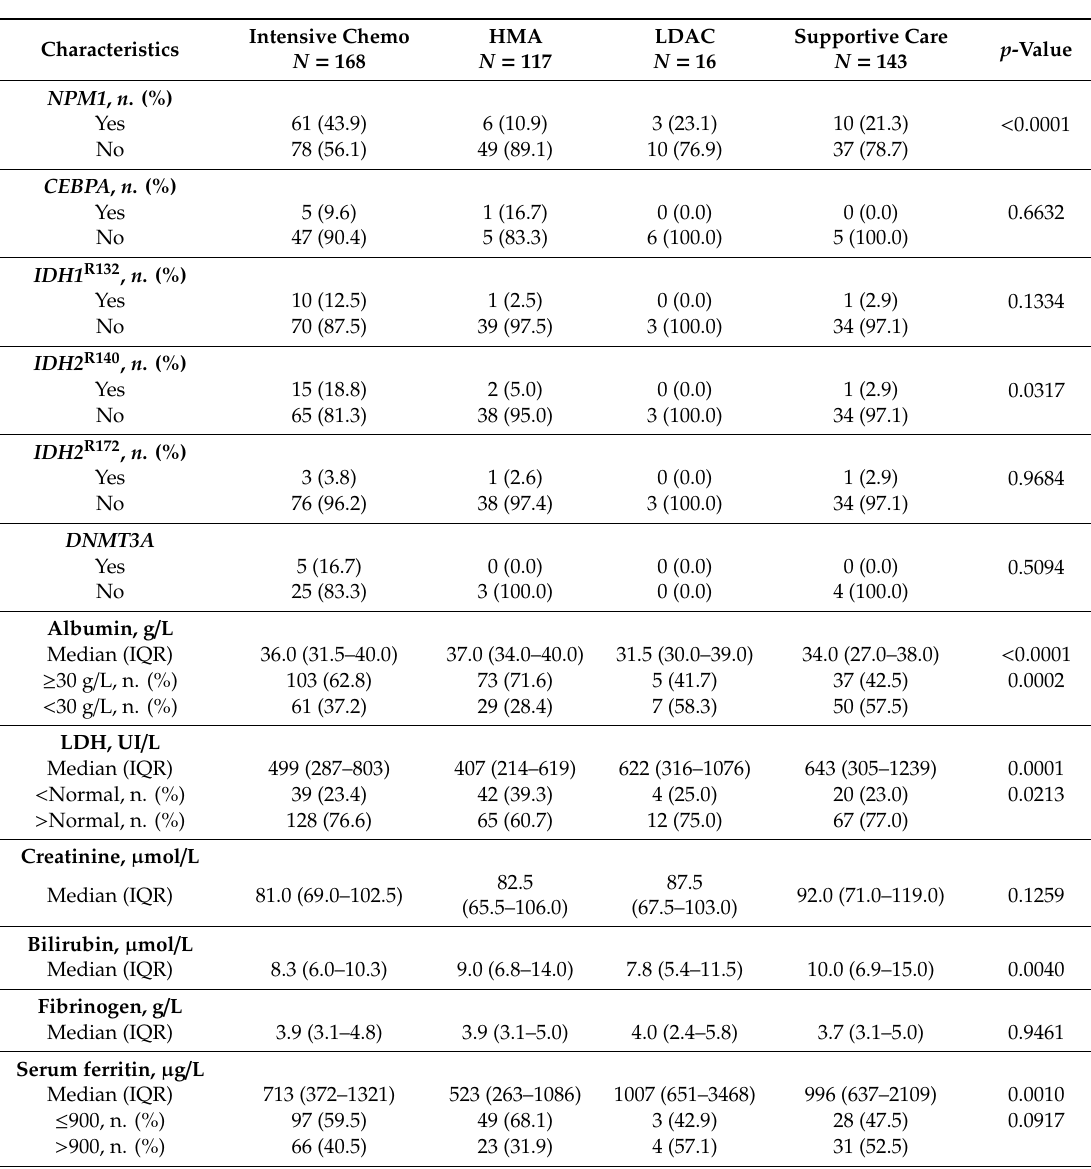
The response to treatment, early death rate, and outcome according to treatments are shown in Table 2. The median OS was 22.6 (6.2-not reached), 10.5 (4.1–19.6), 3.6 (2.4–7.0), 1.1 (0.5–3.5) with intensive chemotherapy, hypomethylating agents, low-dose cytarabine, and supportive care,